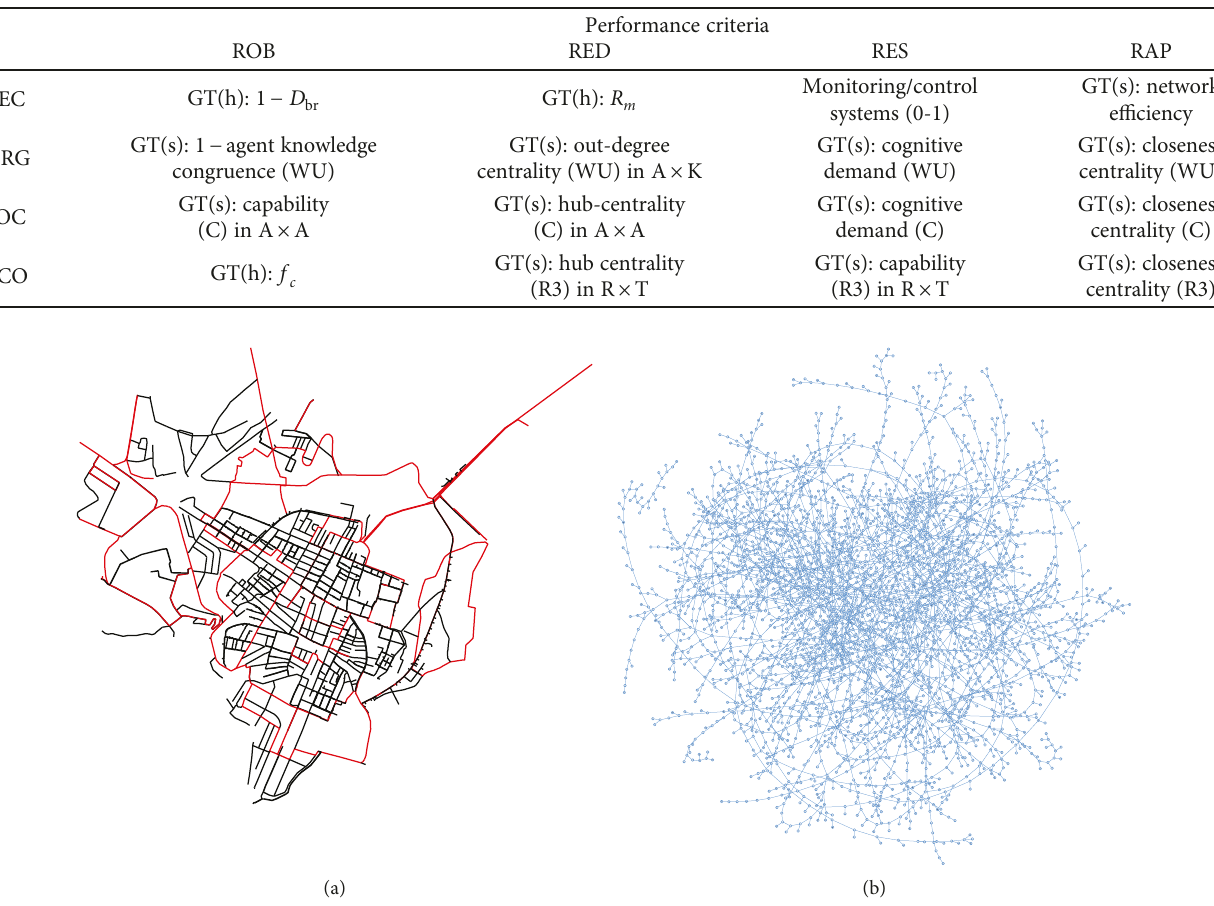
Table 8: GT measures used to assess the performance criteria according to the TOSE approach.